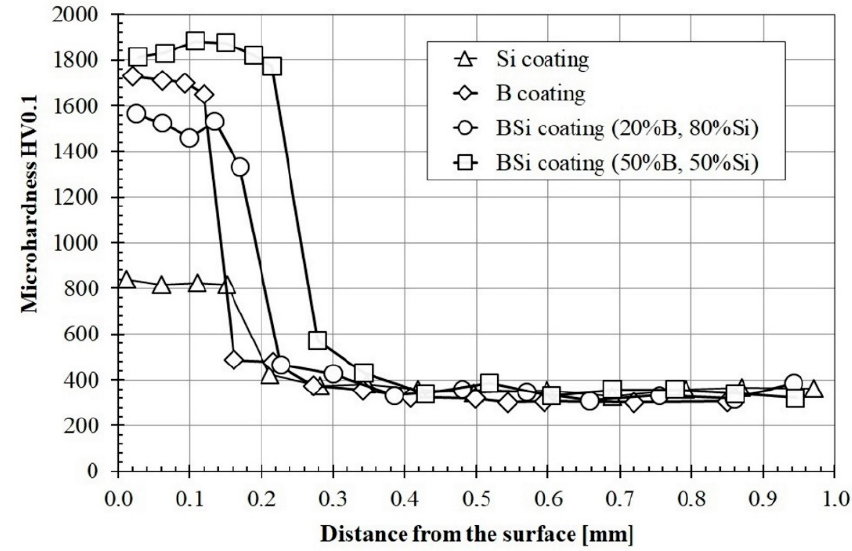
Figure 9. Microhardness profiles of coatings produced using laser processing and pre-coat containing boron, silicon and the B-Si mixture in various proportions.